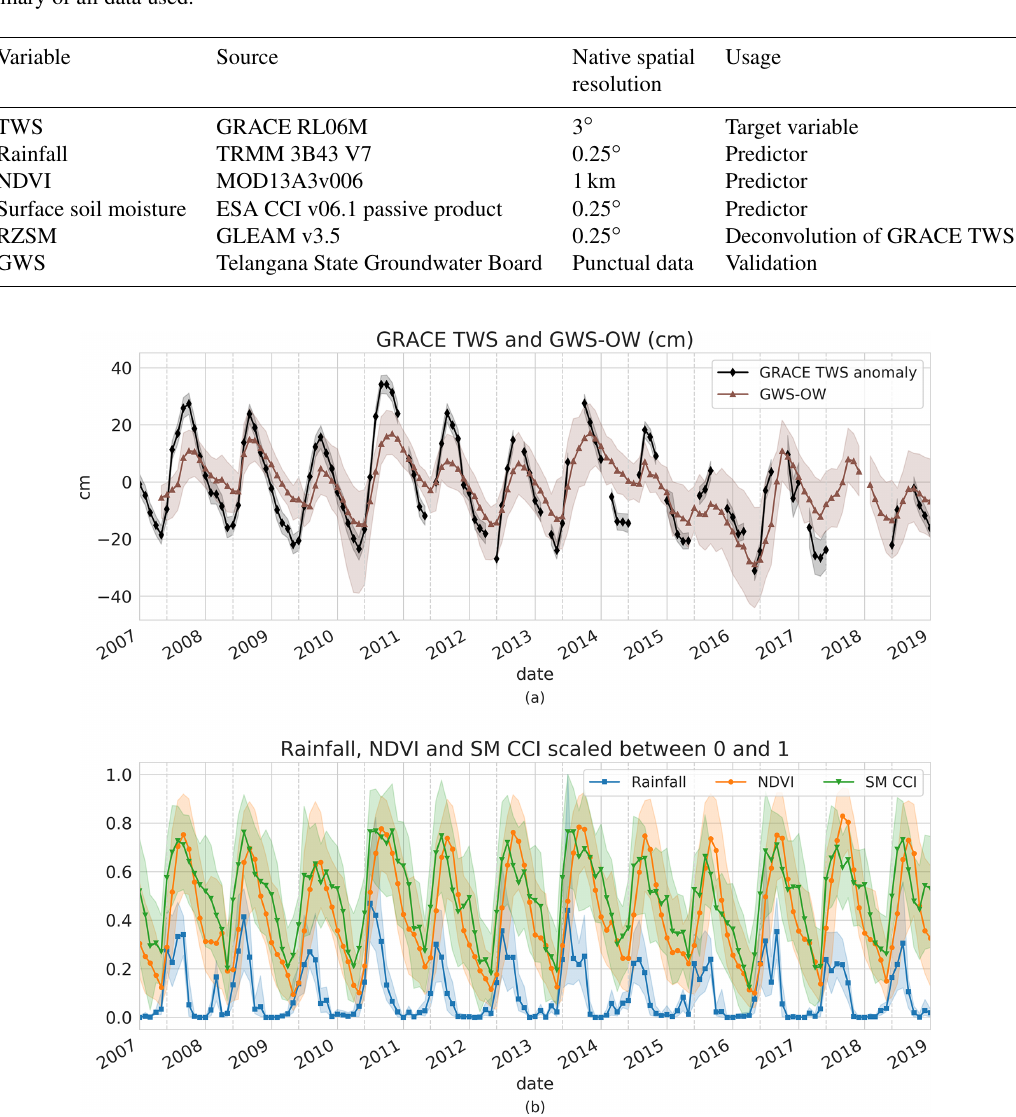
Figure 2. Time series of low-resolution (a) GRACE TWS with its uncertainty envelope (average of the mascon uncertainty resampled at 0.5 ◦ provided with GRACE data) and GWS anomalies derived from in situ measurements (GWS-OW) in centimetres and (b) rainfall, NDVI and SM CCI. Those three predictors were scaled between 0 and 1 to compare their temporal cycles. The envelope for GRACE TWS is the uncertainty provided with the mascon solution, and those for GWS-OW, rainfall, NDVI and SM CCI correspond to the lowest and highest values found in high-resolution (0.5 ◦ ) pixels at each time step. The months of June (beginning of the monsoon) are marked by dotted vertical